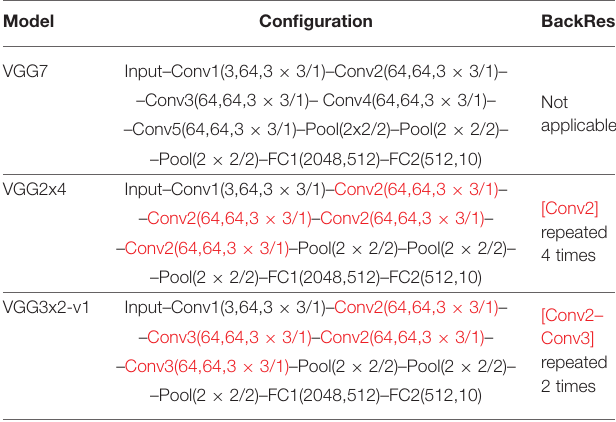
TABLE 3 | CIFAR10 network topologies for Conversion